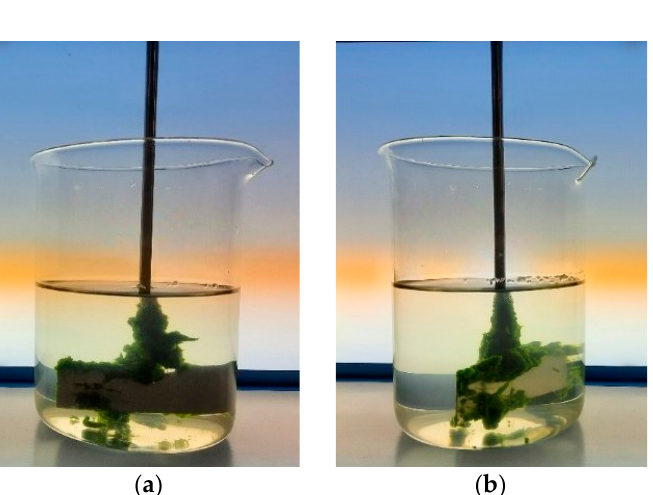
Figure 1. Flocculated C. vulgaris biomass after harvesting at: ( a ) 50 mg L − 1 Zetag 8185; ( b ) 100 mg L − 1 Zetag 8185.